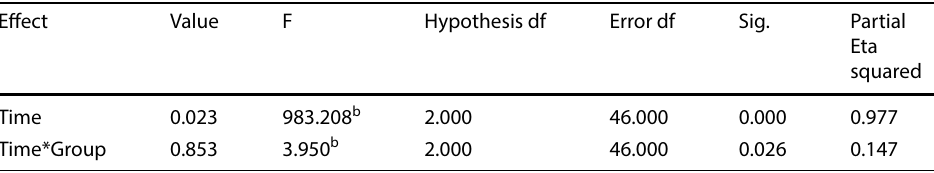
Table 3 Multivariate tests a